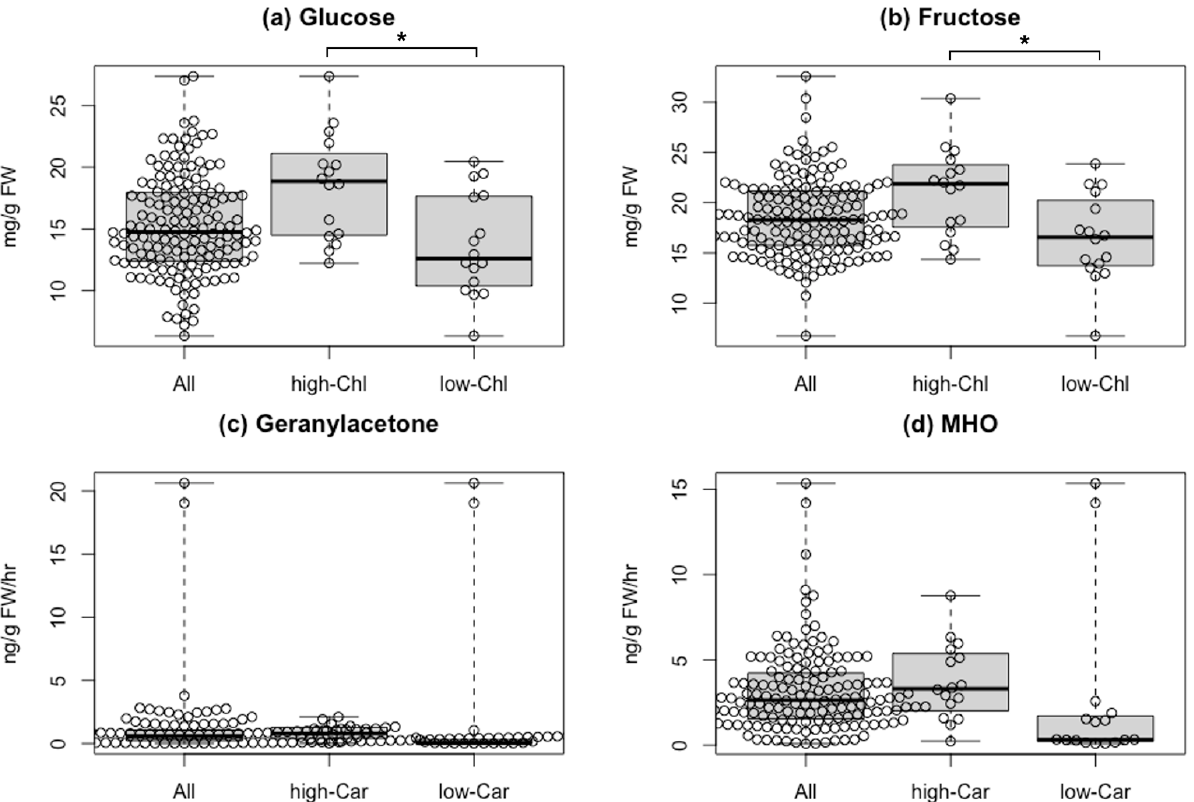
Figure 4. Comparison of flavor-related compounds between varieties with different pigment contents. ( a ) Glucose and ( b ) fructose in fruits of the 156 varieties (All), the top 16 varieties with high chlorophyll a content (high-Chl), and the bottom 16 varieties with low chlorophyll a content (low-Chl). Glucose and fructose contents in fruits of the 156 varieties were obtained from data in Tieman et al. [21]. ( c ) Geranylacetone and ( d ) MHO in fruits of the 157 varieties (All), the top 16 varieties with high total carotenoid content (high-Car), and the bottom 16 varieties with low total carotenoid content (low-Car). Geranylacetone and 6-methyl-5-hepten-2-one (MHO) contents in fruits of 157 varieties were obtained from Tieman et al. [21]. Asterisks represent a significant difference (* p < 0.05) assayed by Welch’s t -test. Abbreviation: FW, fresh weight.